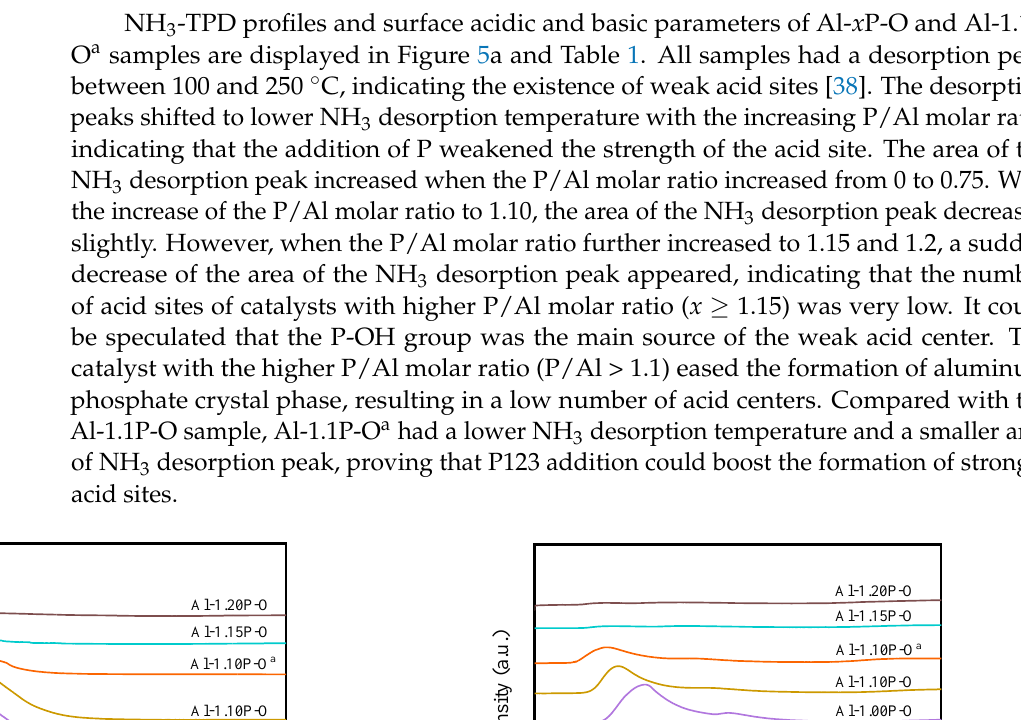
Figure 4. FT-IR spectra of Al- x P-O and Al-1.1P-O a samples. NH 3 -TPD profiles and surface acidic and basic parameters of Al- x P-O and Al-1.1P-